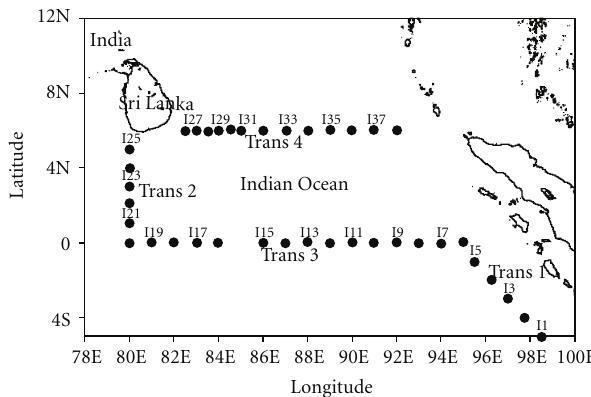
Figure 1: Map of the Indian Ocean, showing the sampling sites (solid circles) during the cruise dated from 12 April to 4 May,